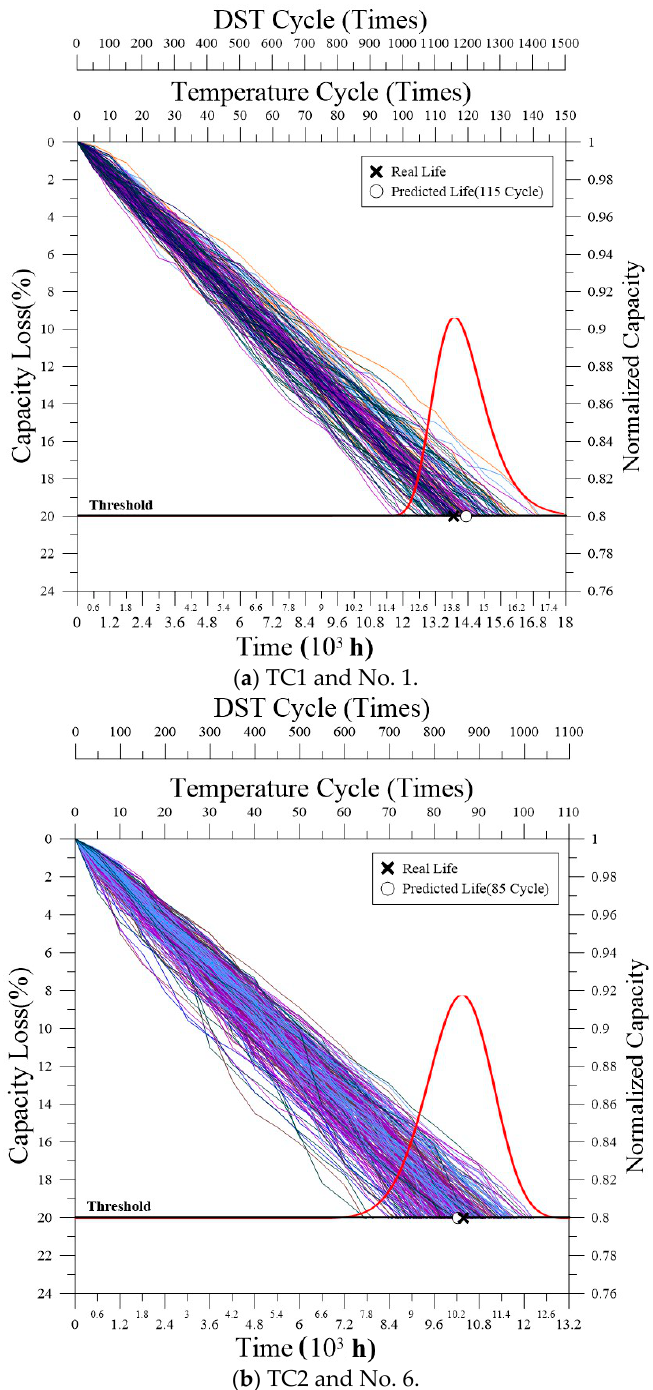
Figure 8. Lifetime prediction of the last TC for two test batteries in different temperature cycles.